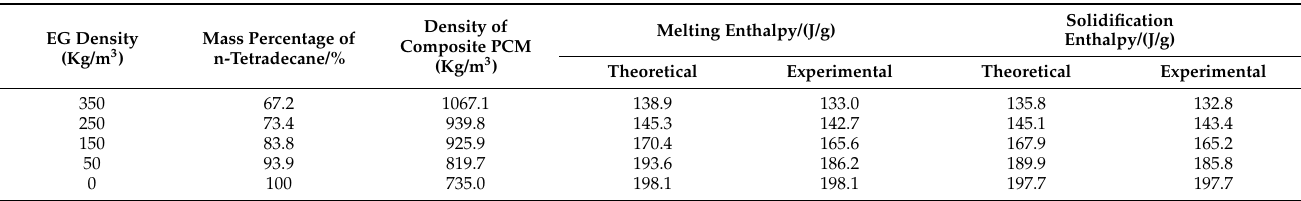
Table 1. Phase change enthalpy of the n-tetradecane/EG with different EG density. EG Density (Kg/m 3 )